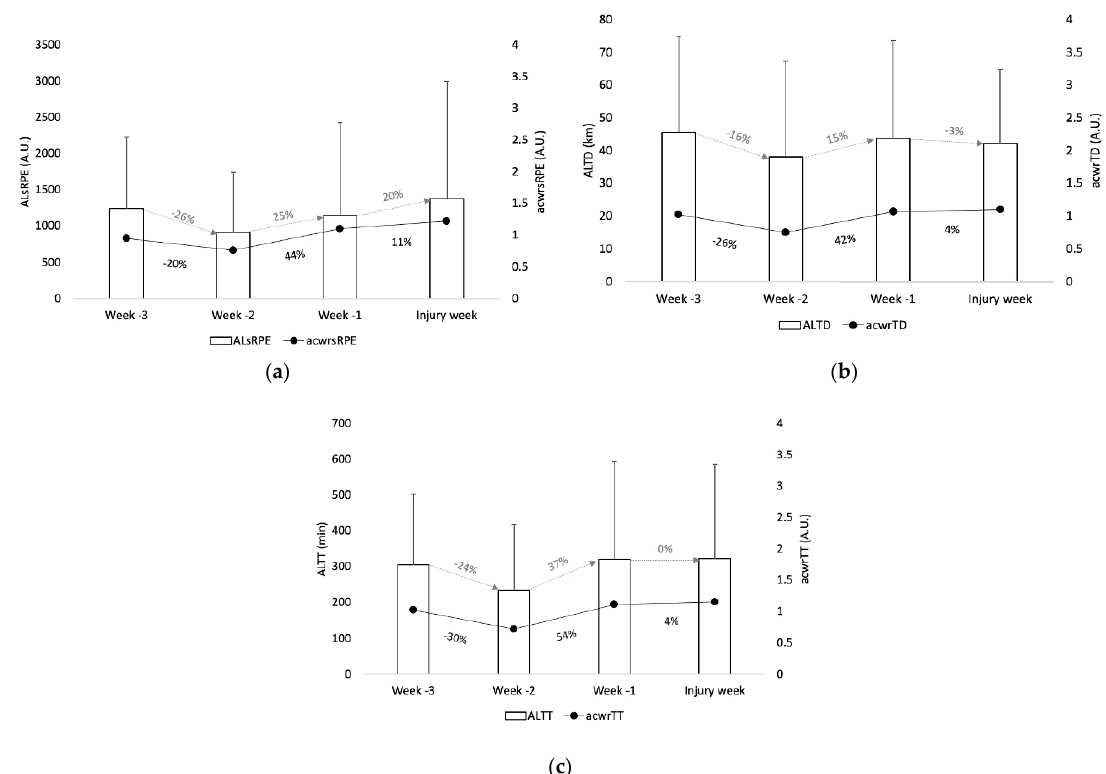
Figure 1. Descriptive statistics (error bar: mean and standard deviation of acute load; black circle: mean of acute: chronic workload ratio (acwr)) of ( a ) session rate of perceived exertion (sRPE), ( b ) total distance (TD), and ( c ) training time (TT) in the three weeks (w) prior injury occurrence. The grey number (%) represents the percentage of changes from one week to another for acute load and the black number (%) represents the percentage of change from one week to another in ACWR.